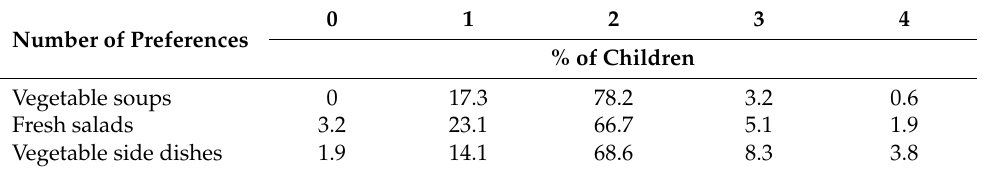
Table 5. Vegetable preferences on the basis of vegetable soup, salad and vegetable side dishes (A5).